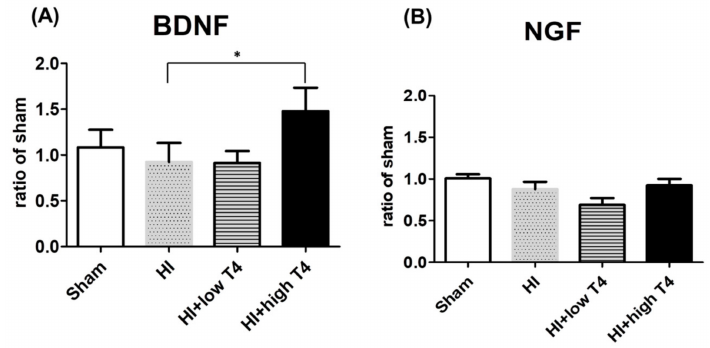
Figure 3. Thyroxin treatment upregulated brain-derived neurotrophic-factor (BDNF) expression in injured WM. ( A ) BDNF mRNA expression in WM was significantly upregulated in the HI+high T4 group compared to the HI group; ( B ) nerve growth factor (NGF) mRNA expression in WM was not significantly different between the HI and HI+T4 groups. * p <